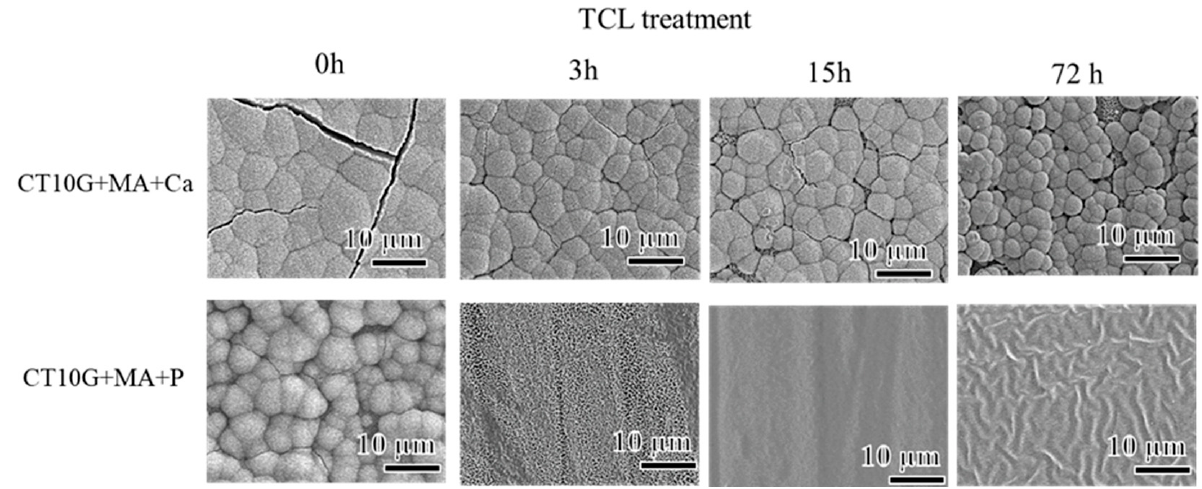
Figure 6. SEM images of surfaces of Ca–heat-treated Ti–6Al–4V alloy soaked in SBF for 7 days following dip coat and subsequent thermal cross-link treatment.